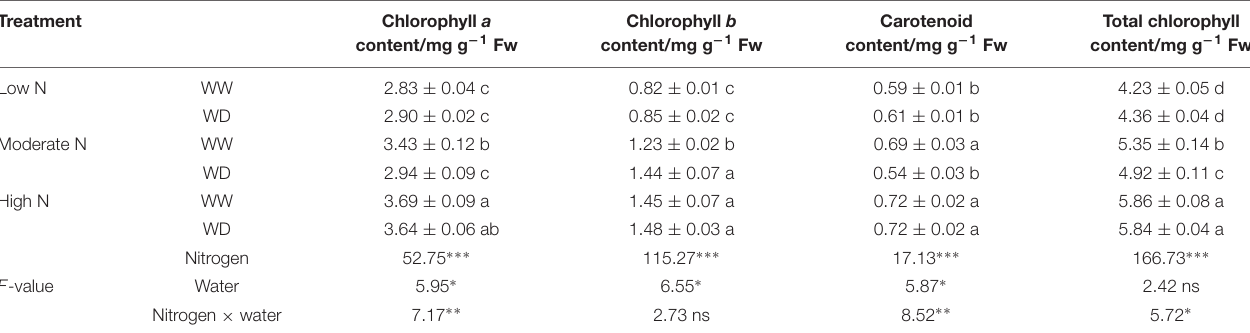
TABLE 1 | Comparison in chlorophyll contents of rice plants grown under different nitrogen and water conditions.